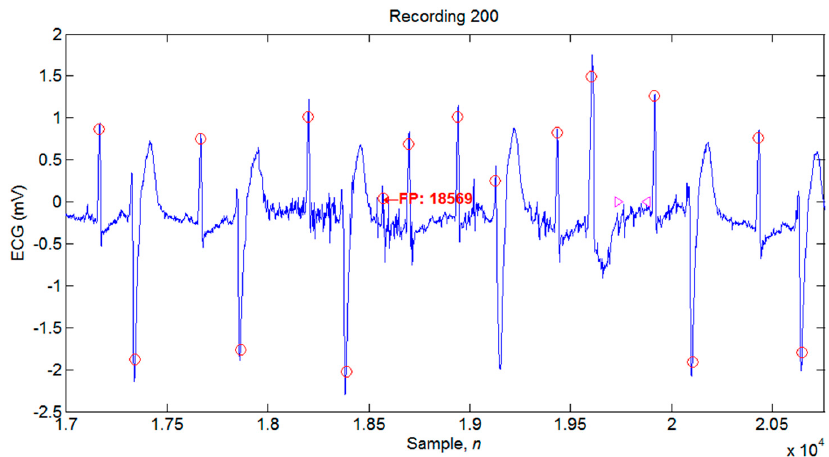
Figure 12. Illustration of the detection failure caused by sudden high-frequency noises.